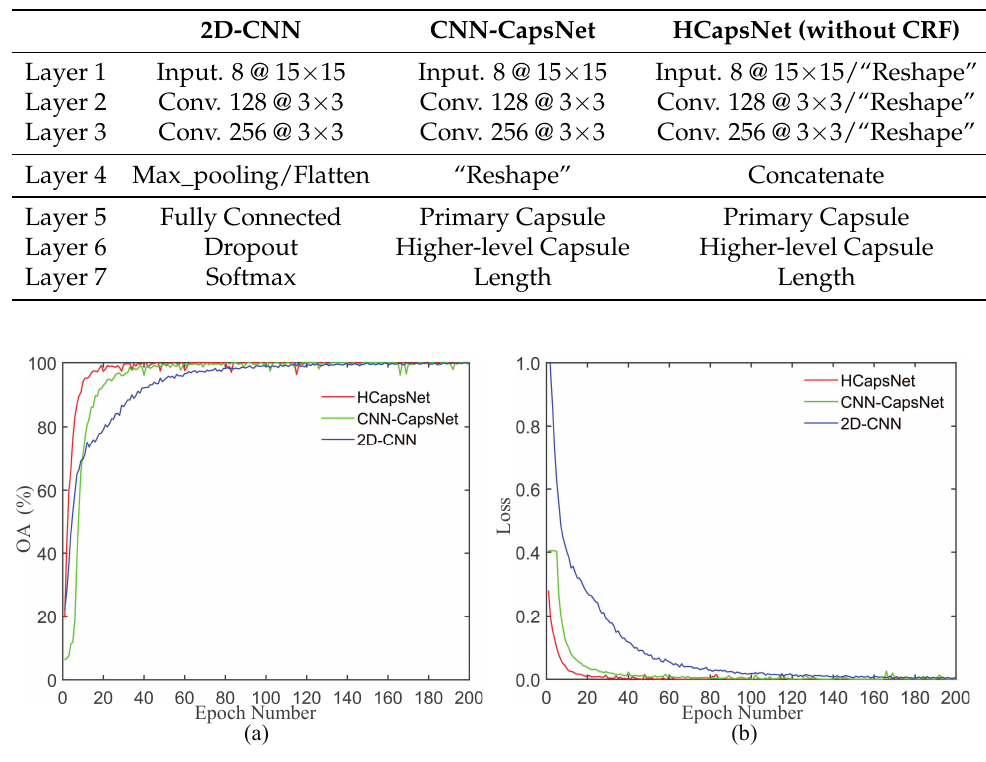
Table 9. A brief description of structures and parameters.